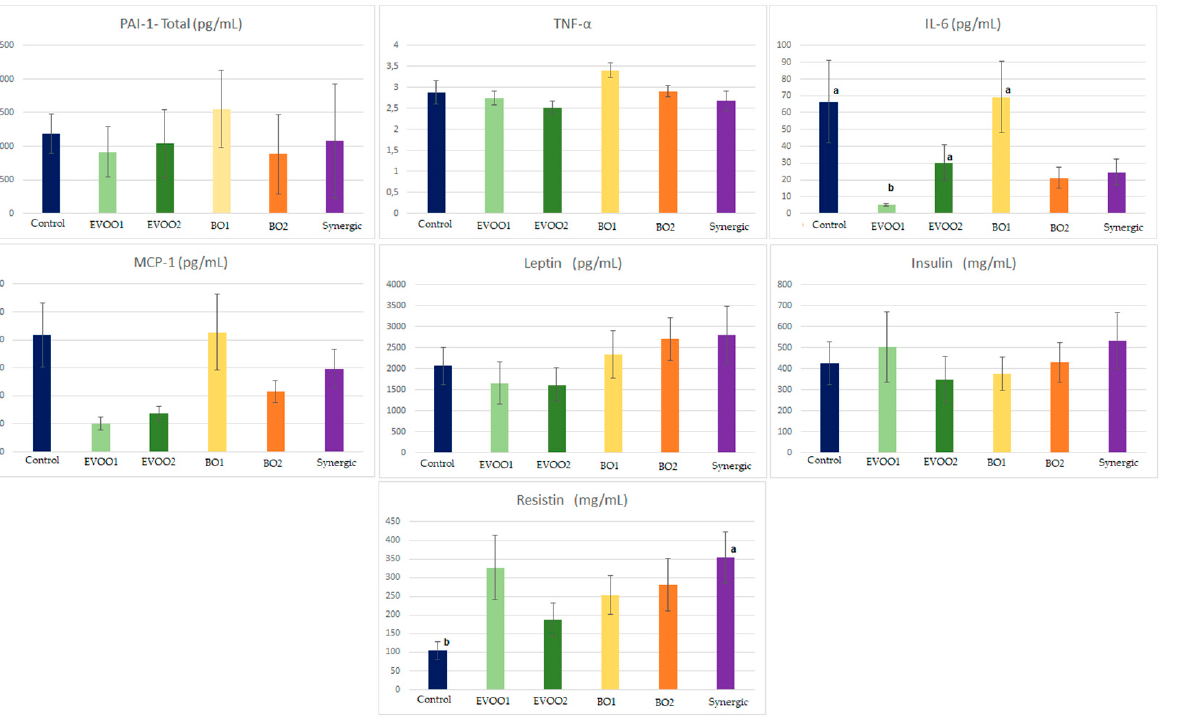
Figure 7. Concentration of cytokines in the serum after 90 days of supplementation. C, control group (without lipidic supplementation); EVOO1, extra virgin olive oil (1000 mg/kg); EVOO2, extra virgin olive oil (2000 mg/kg); BO1, crude buriti oil (1000 mg/kg); BO2, crude buriti oil (2000 mg/kg); S, synergic—BO1 + EVOO1. The values represent the mean ± standard error of the mean. For the total PAI-1 ( p = 0.119), TNF- α ( p = 0.063), MCP-1 (0.066), leptin (0.467), and insulin (0.583), there was no significant difference between the groups. ANOVA, followed by Tukey’s post hoc test. For IL-6 and resistin, the values differed between them ( p = 0.003 and 0.025, respectively), according to ANOVA followed by Dunn’s post hoc test. Notes: a : indicates the group with the lowest value for the analyzed parameter and that differed from the group with letter b ; ab : indicates the group that did not differ statistically from the groups with the highest and lowest value for the analyzed parameter ( a and b ); b : indicates the group with the highest value for the analyzed parameter and that differed from the group with letter a .